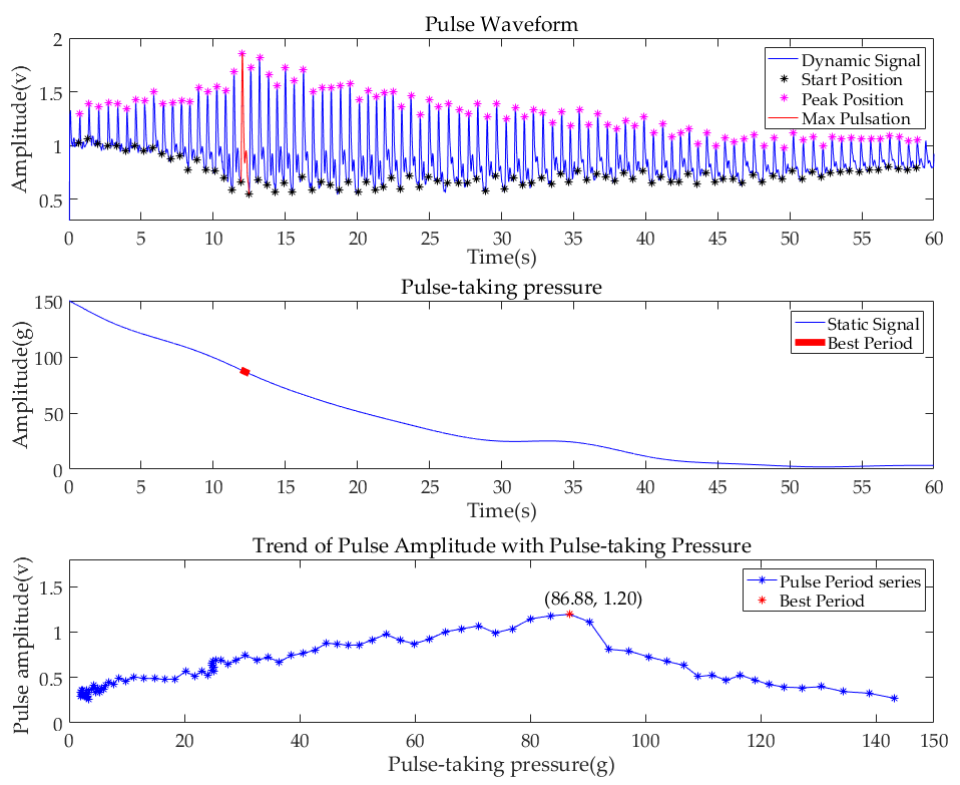
Figure 12. Pulse diagrams of subject (No.6) at the Chi region.